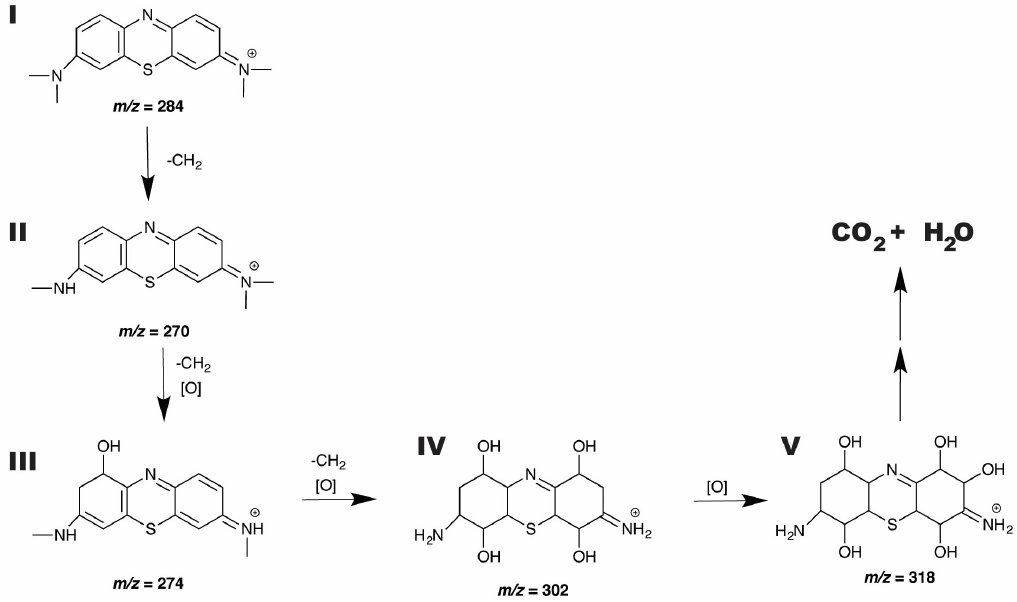
Figure 12. Schematic representation of suggested methylene blue photocatalytic degradation